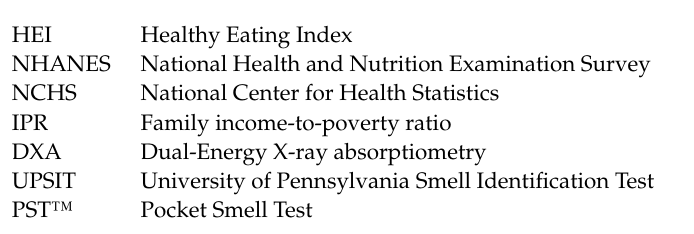
Table S1: Estimates (SE) for the association between the interaction of olfactory function status and body fat percent with dietary intake among U.S. adults >40 years in NHANES 2013–2014; Table S2: Estimates (SE) for the association between the interaction of olfactory function status and